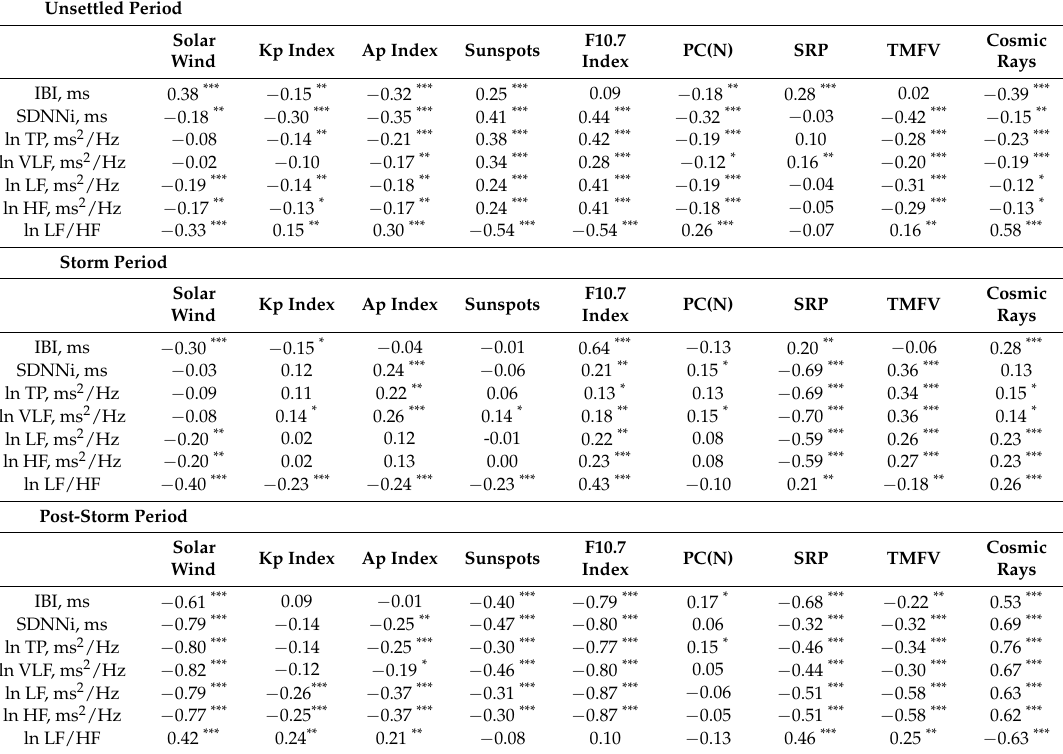
Table 4. Correlations between HRV and environmental